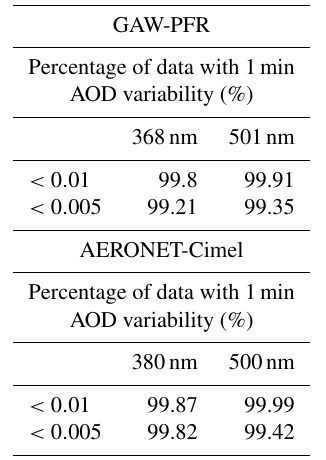
Table 6. Percentage of AOD data with variability within 1min of less than 0.01 and 0.005, using AOD data from GAW-PFR (at 368 and 501nm) and AERONET-Cimel (at 380 and 500nm), respec- tively, for 2013. A total of ∼ 32000 data pairs per channel have been used from GAW-PFR and 20117 triplets (60351 individual AOD measurements) from Cimel no. 244 have been used to calcu- late the AOD